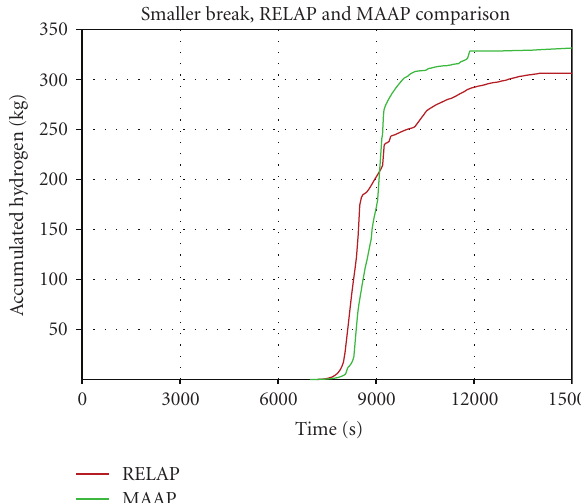
Figure 10: Mass of accumulated hydrogen, Group 1.